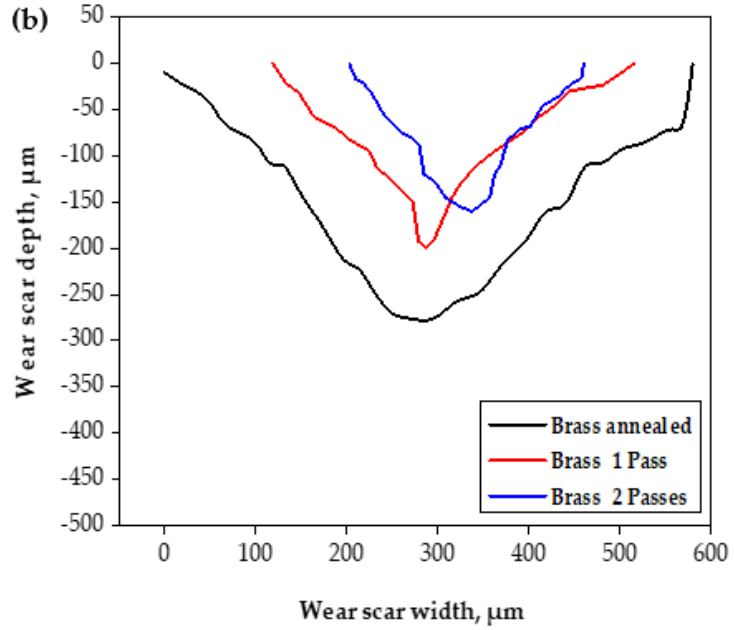
Figure 10. Cross-sectional profiles of the wear scars of the ( a ) Cu and ( b ) brass tubes after the wear test, under an applied load of 50 N and a sliding distance of 1375.2 m.